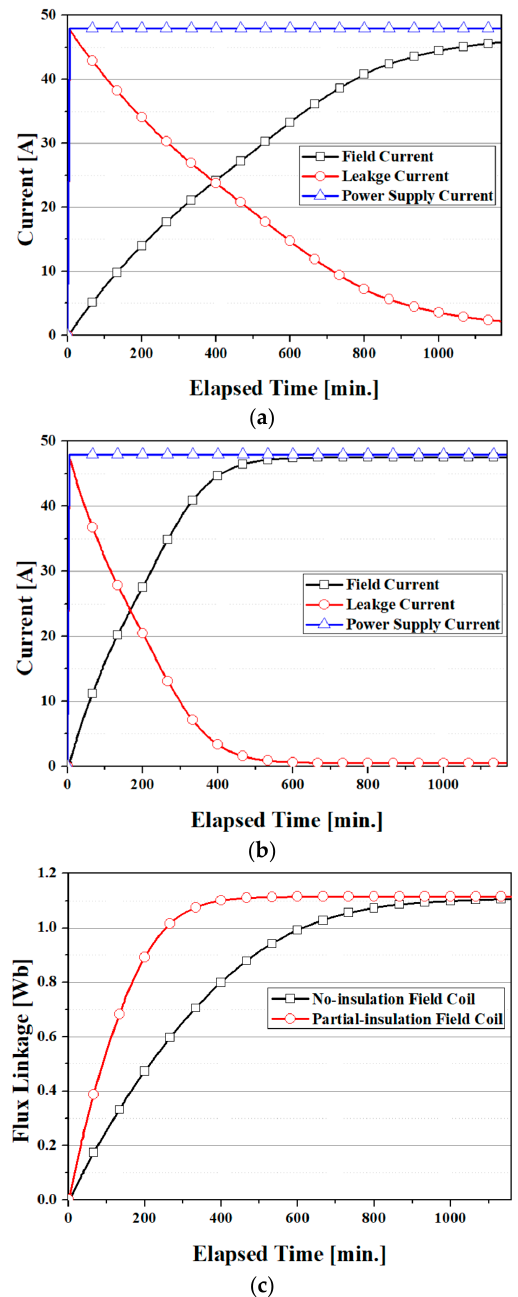
Figure 12. Current and flux charging characteristics of the HTS HSMs: ( a ) current charging character- istics of the HTS HSM using the NI HTS field coil, ( b ) current charging characteristics of the HTS HSM using the PI HTS field coil, and ( c ) flux linkage in phase